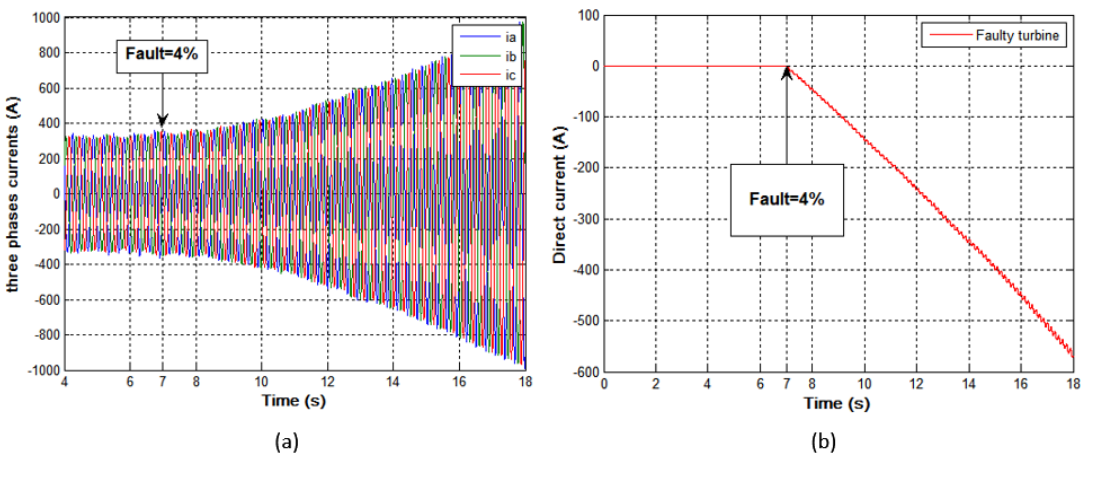
Figure 3. The effect of an inter-turn short circuit fault of severity 4% at time 7 s before the AFTC: ( a ) the three-phase currents of the faulty machine and ( b ) the direct current of the faulty